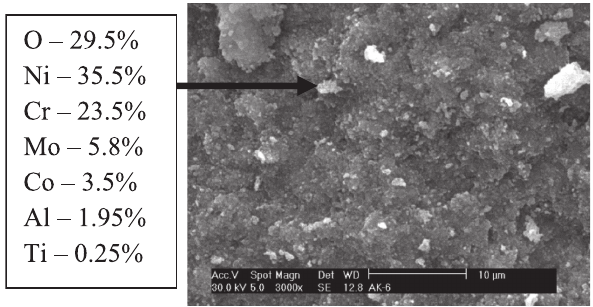
Fig. 6: EDAX results confirming presence of oxide of Ni and Cr on the sample exposed at 900 °C in mixed salt environment